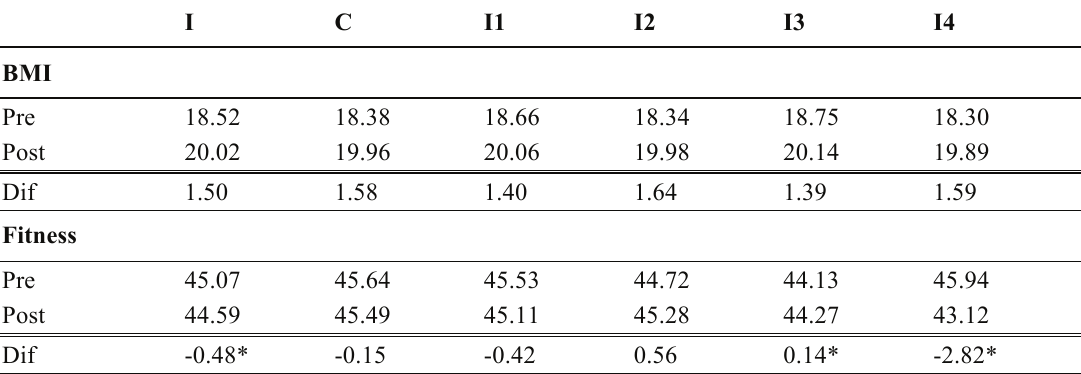
Table 2. Pre and post difference in mean by control and intervention schools I C I1 I2 I3